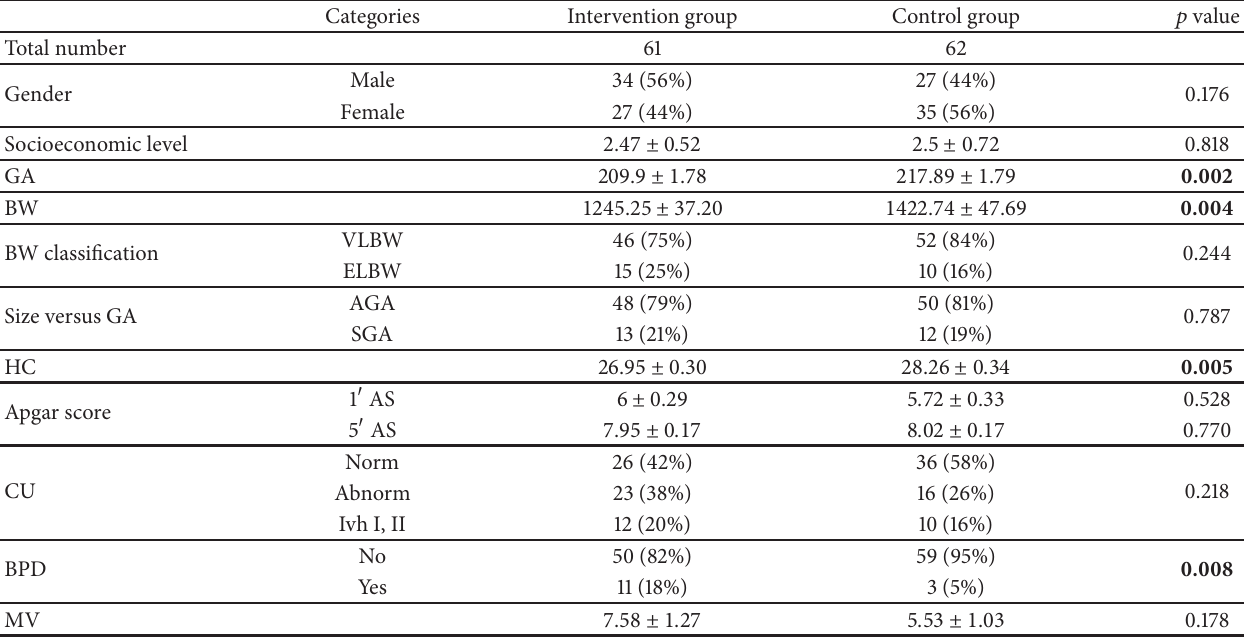
Table 2: Comparisons between intervention and control groups on the basis of both demographic and clinical